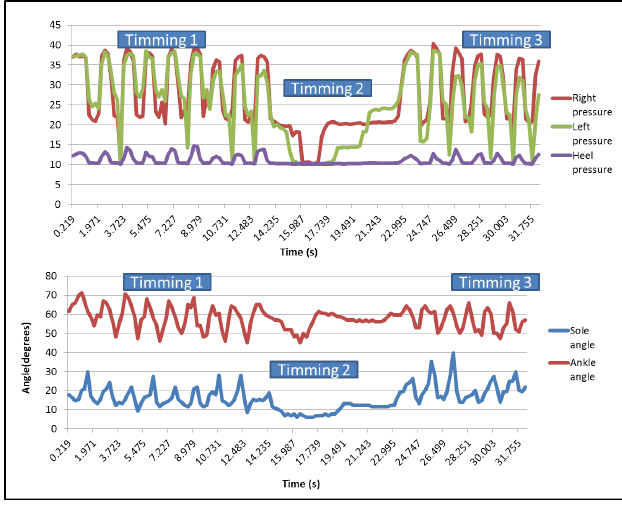
Figure 22. Pressure and bending sensors curves of normal